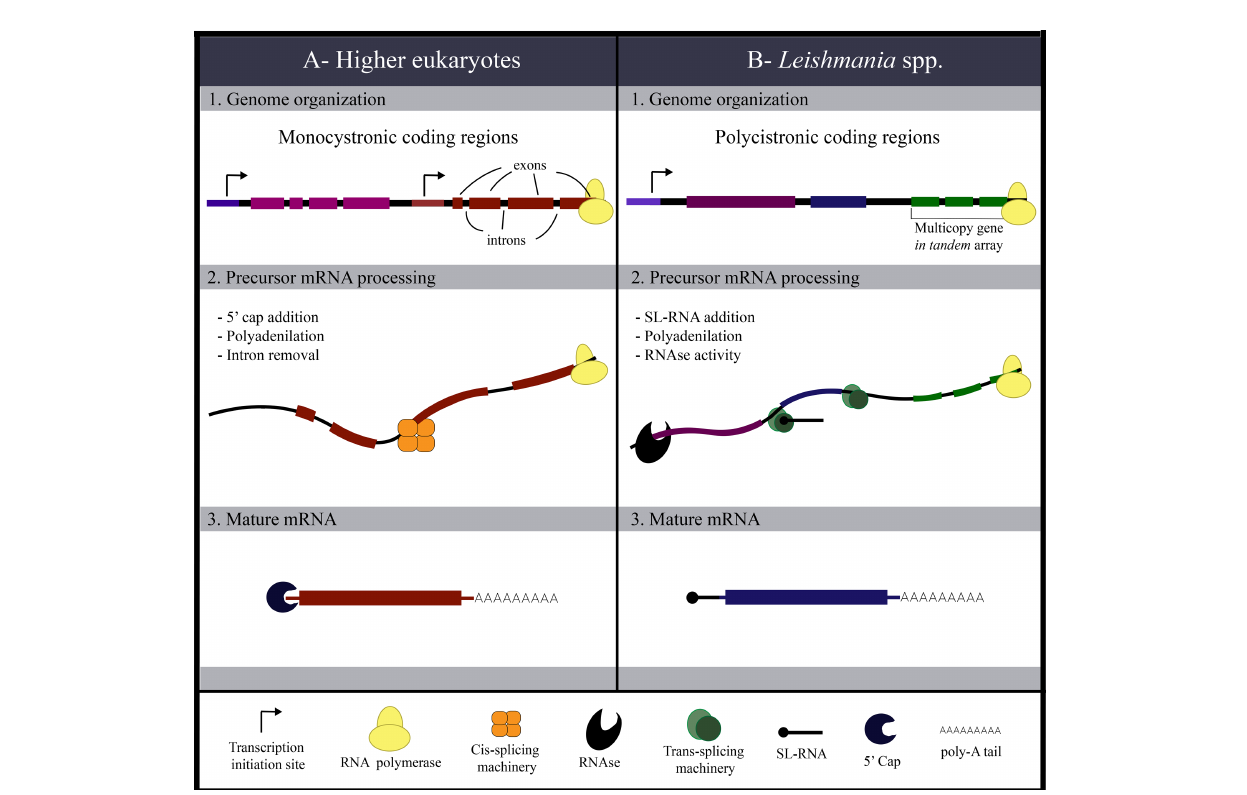
FIGURE 3 | Main aspects of polycistronic and monocistronic gene expression. (A) Monocistronic coding regions are common to most higher eukaryotes. With this genome organization, protein-coding genes are organized within intronic portions that are nonprotein-coding regions. Transcription is regulated by promoters and enhancers; thus, transcription is individually controlled. Processing of precursor mRNA involves the removal of introns, 5 ’ cap addition and polyadenylation, generating the mature mRNA molecule that is translated after export from the nucleus. (B) The polycistronic organization of coding genes differentiates Leishmania gene expression. The absence of transcriptional control is shown, with several genes encoded in the same polycistronic coding region being transcribed together. Another difference is the existence of multicopy genes in tandem arrays. All these characteristics point to uncontrolled transcription. Processing of precursor mRNA involves trans -splicing (addition of the SL molecule), polyadenylation and RNAse activity to eliminate mRNAs that will not be